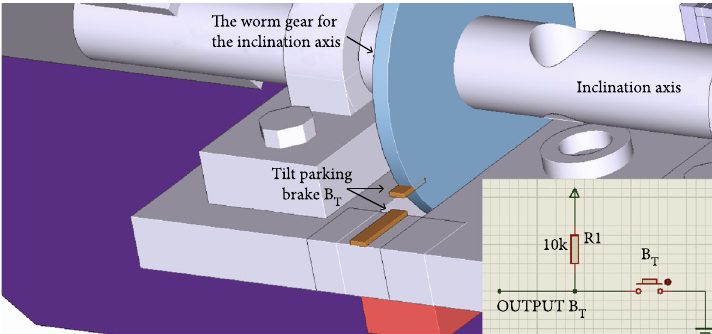
Figure 35: The tilt parking brake B